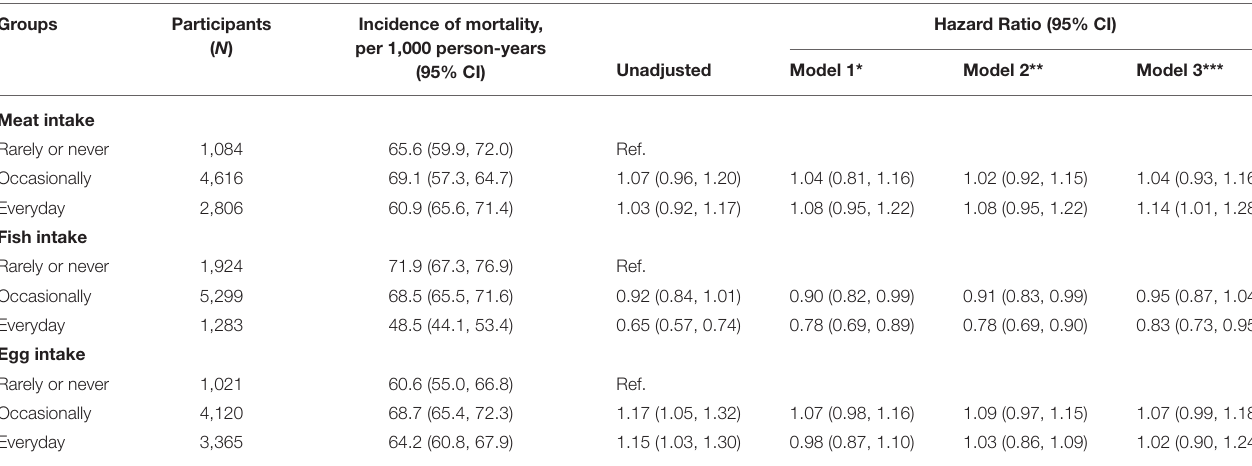
TABLE 2 | Hazard ratio and 95% Confidence Interval (CI) of meat, fish, and egg on mortality.